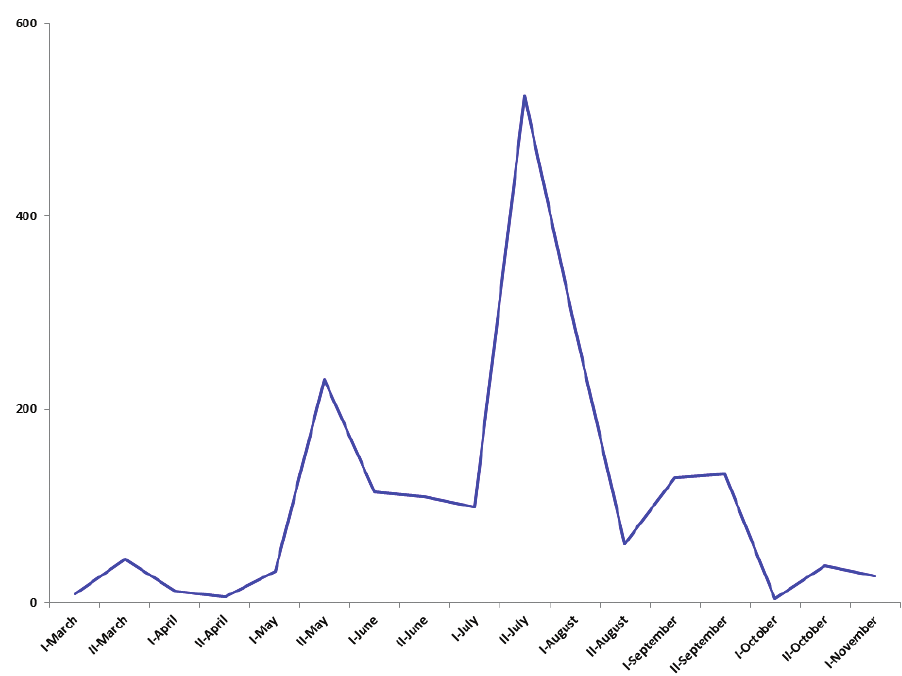
Figure 3. Specimens of Microgastrinae collected in Ottawa bi-weekly (March-November), based on CNC holdings only